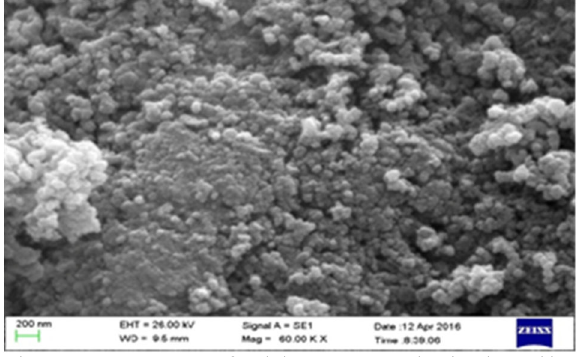
Fig. 2. Image of laboratory-synthesized Ni/Fe nanoparticles on AC obtained with a field-emission scanning electron microscpe (SEM) (60.00 Kx). Eighty percent particles had diameters less than 100